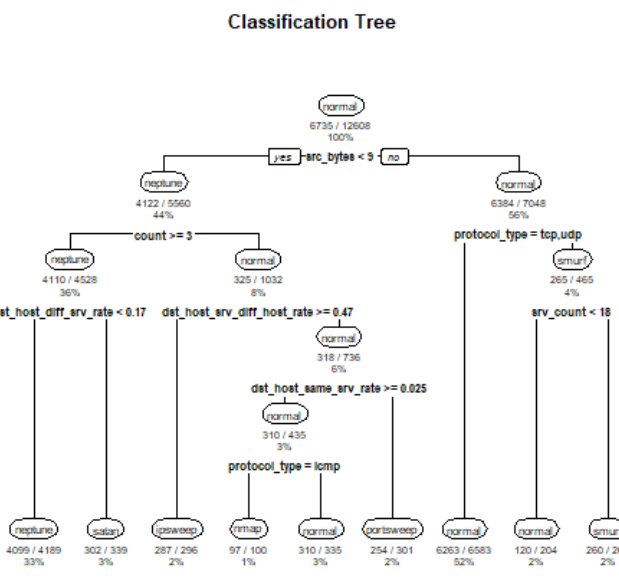
Figure 38. Decision Tree results of the NSL-KDD dataset.